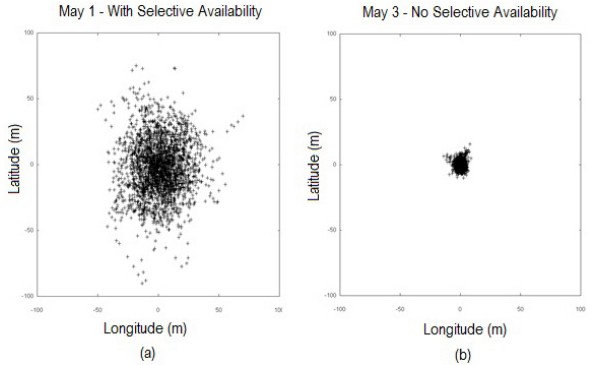
Figure 3. Example of a localization system with selective avail- ability (a) and nonselective availability (b) (source: United States